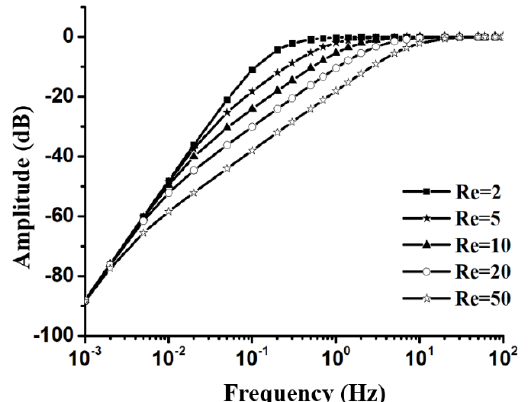
Figure 3. Vibration process with different equivalent flow resistances caused by the temperature- based viscosity, according to Equation (5).